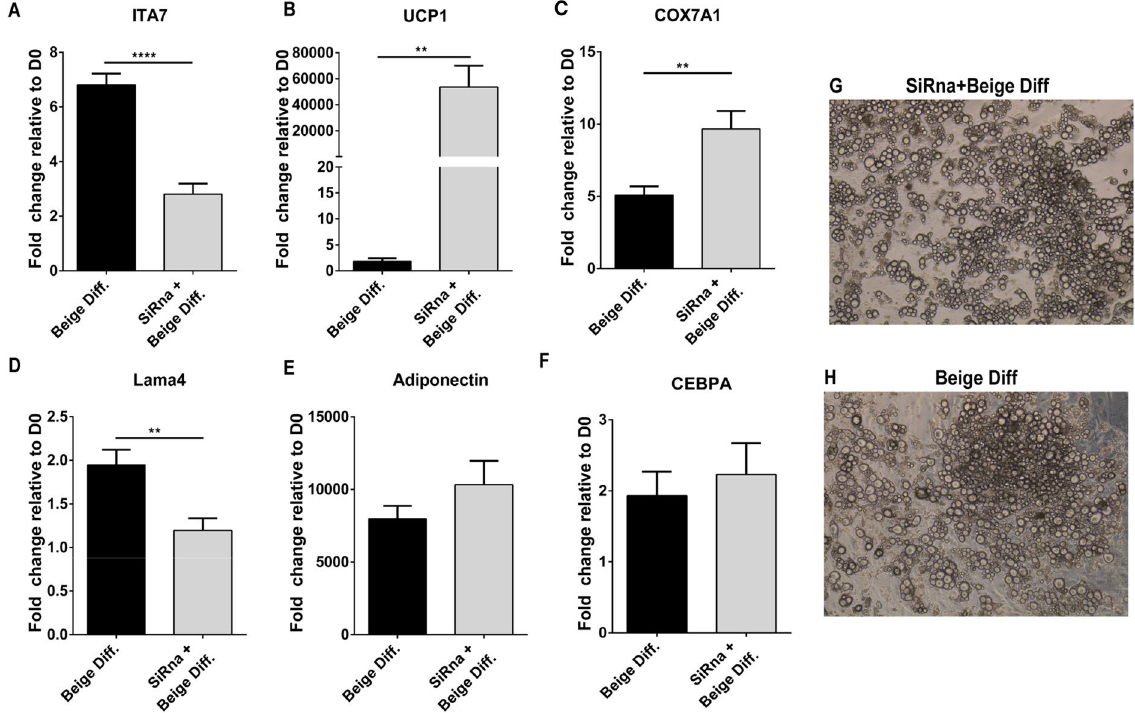
Figure 7. Effect of ITA7 knockdown on beige adipocyte differentiation and LAMA4 expression. ( A ) Efficacy of ITA7 siRNA in knocking down levels of ITA7 in ASC differentiated to beige adipocytes (**** p < 0.0001). ( B ) UCP1 (** p = 0.0055), ( C ) COX7A1(**p < 0.01), ( D ) LAMA4 (** p = 0.0021), ( E ) adiponectin and ( F ) CEBPA expression in ITA7 knockdown cells. n = 3 experiments with 3 replicates per group per experiment. ( G – H ) Representative brightfield images showing lipid loading of the adipocytes with or without ITA7 knockdown. Values are means ± standard errors, from unpaired t test with Welch’s correction. Two tailed p value was